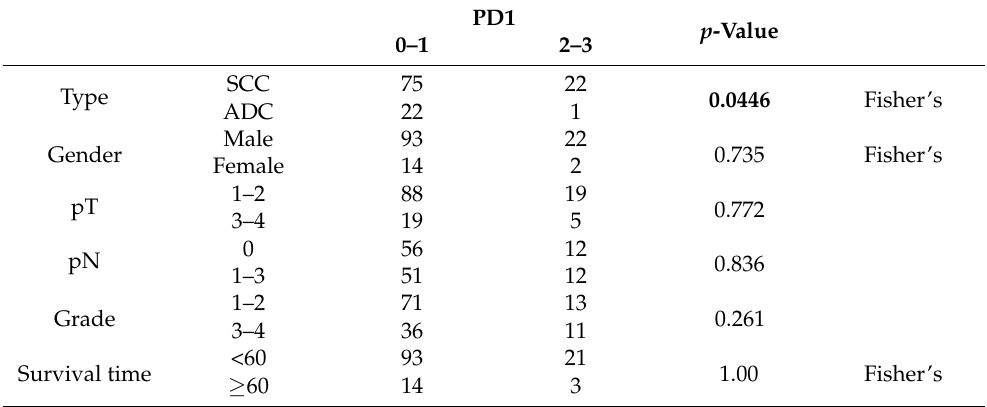
Table 1. Correlation between PD1 expression and clinicopathological parameters in primary lung tumor.